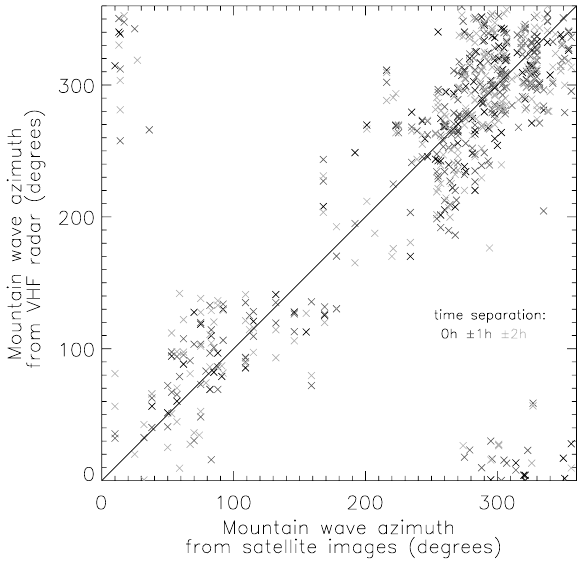
Fig. 12. Mountain-wave azimuths from VHF radar and satellite images, 1996–2006. Wave azimuth from satellite is perpendicular to cloud lines, pointing upwind. Time separation between radar and satellite data is 0, 1 or 2h. The diagonal line is for equal radar and satellite